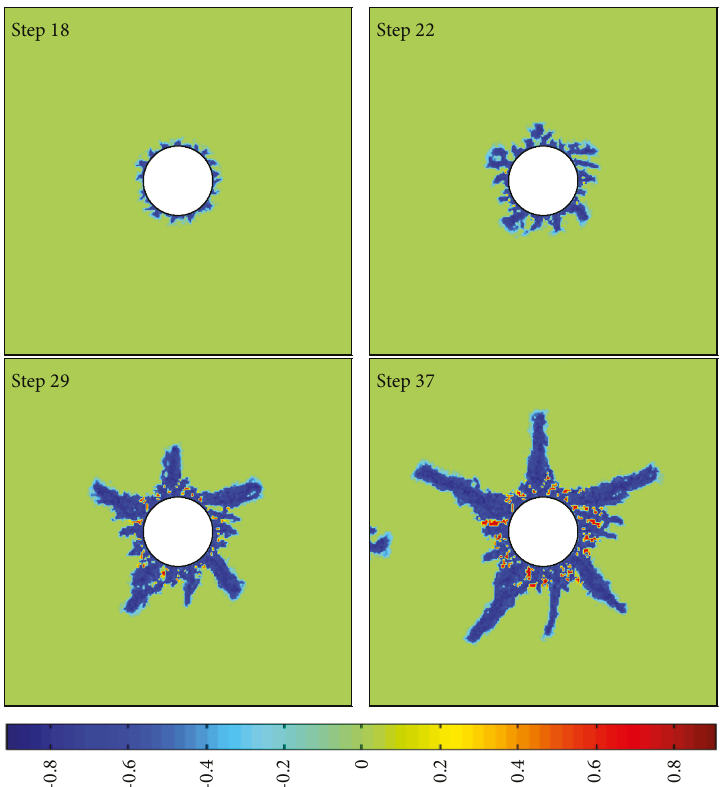
Figure 5: Distribution and evolution of the fracture in the intact sample.